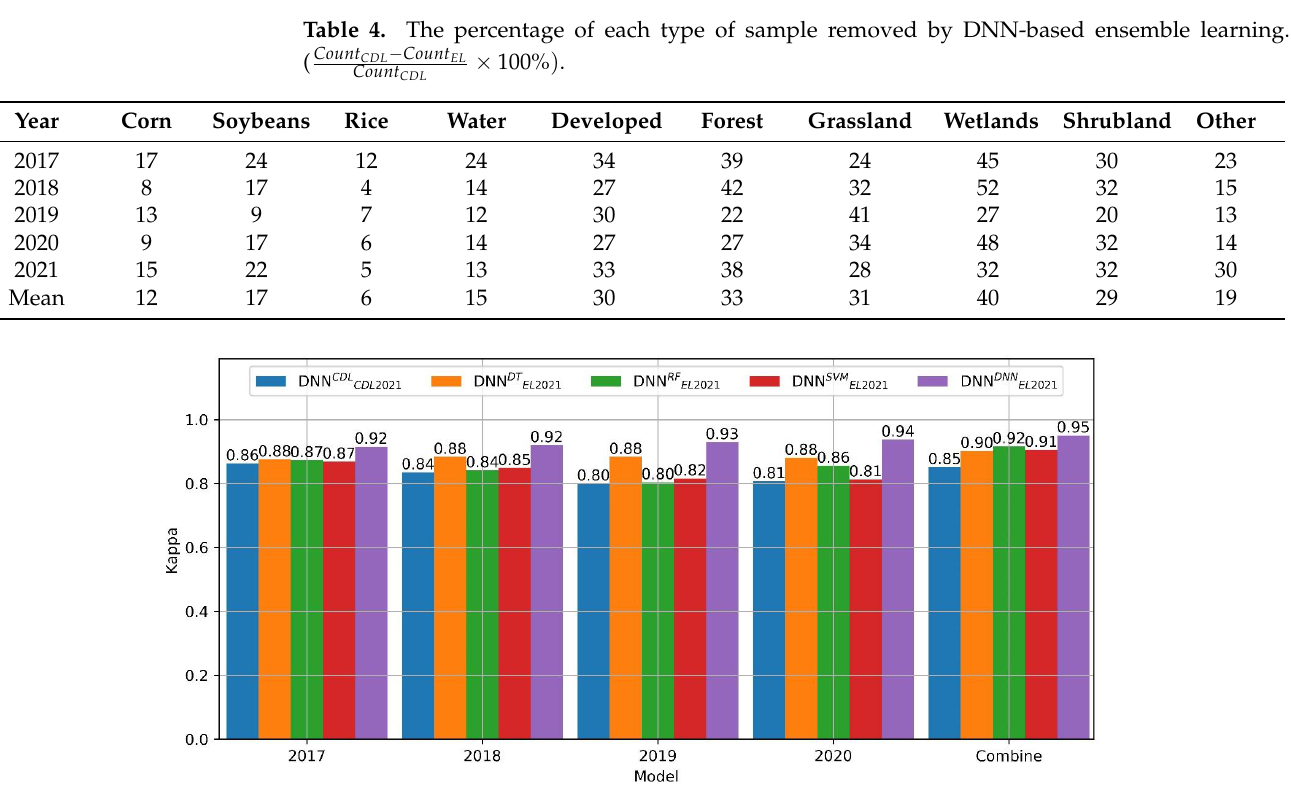
Table 3. The percentage of samples removed by the ensemble learning of the four algorithms each year. ( 𝐶𝑜𝑢𝑛𝑡 𝐶𝐷𝐿 −𝐶𝑜𝑢𝑛𝑡 𝐸𝐿